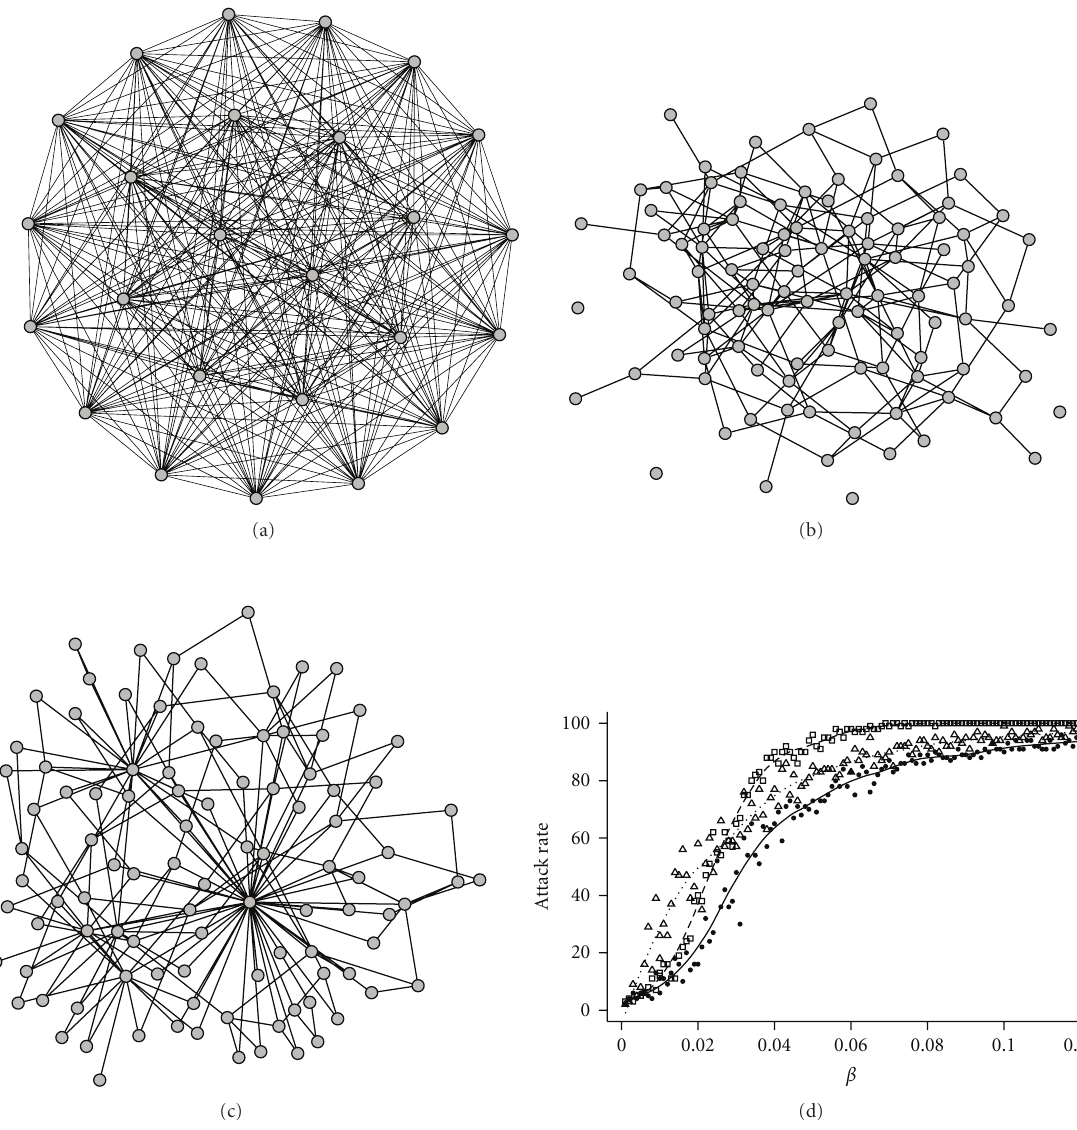
Figure 2: Three examples of contact networks with identical number of nodes (with 100 nodes) and connectedness (where the mean number of e ff ective contacts per node = 4), but di ff erent degree distributions. (a) Fully-connected network. Each node has a degree of 99, but a weight of 4/99 = .0404 is applied to each edge to keep the average connectedness of each node equal to four. Diseases spread through this network in an equivalent way as in a mass action model. For clarity, only 25 nodes out of 100 are represented here. (b) Random network with Poisson degree distribution and mean degree = 4, generated following the Erdos and Renyi model [5]. (c) Scale-free network generated using Barbasi- Albert’s preferential attachment algorithm [6], with mean degree = 4 and a power law degree distribution. The network is created by starting with one node and no edges. At each time step, a node is added and connected to two other vertices chosen in proportion to their current degree. This network is characterized by a few highly connected nodes, which may act as superspreaders during epidemics. (d) Stochastic SIR simulations of disease dynamics through the three networks (120 runs per network type). Squares, circles and triangles correspond to networks (a), (b), and (c), respectively. The final epidemic size (attack rate) is represented in relation to the intergroup transmission β . The recovery rate is fixed at 0.1. Note that even when the mean connectivity is kept constant, disease impacts vary with network